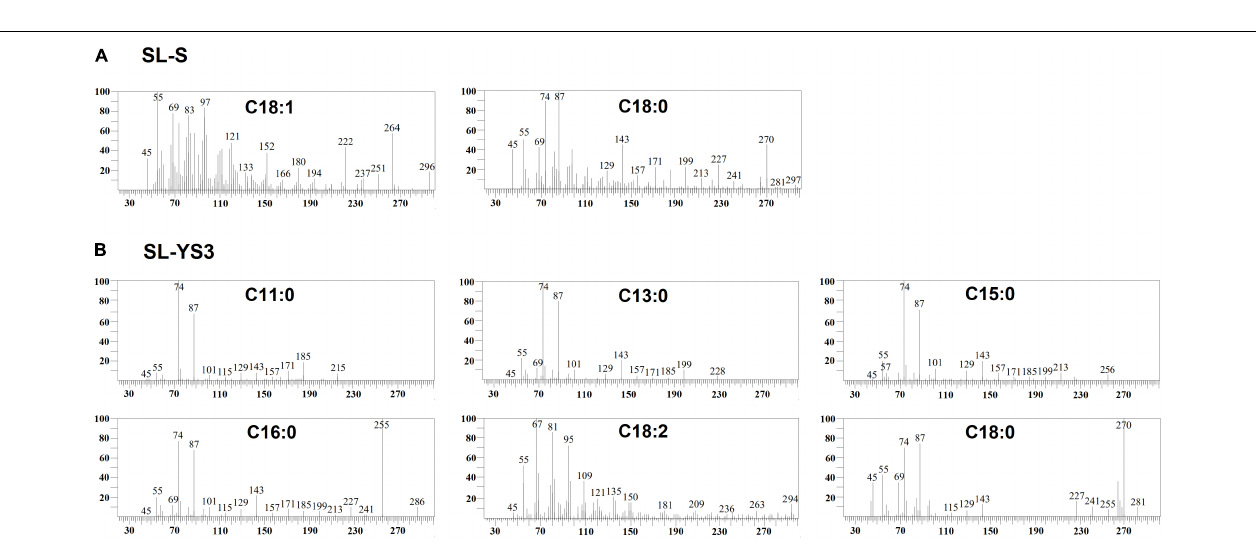
Frontiers in Microbiology |